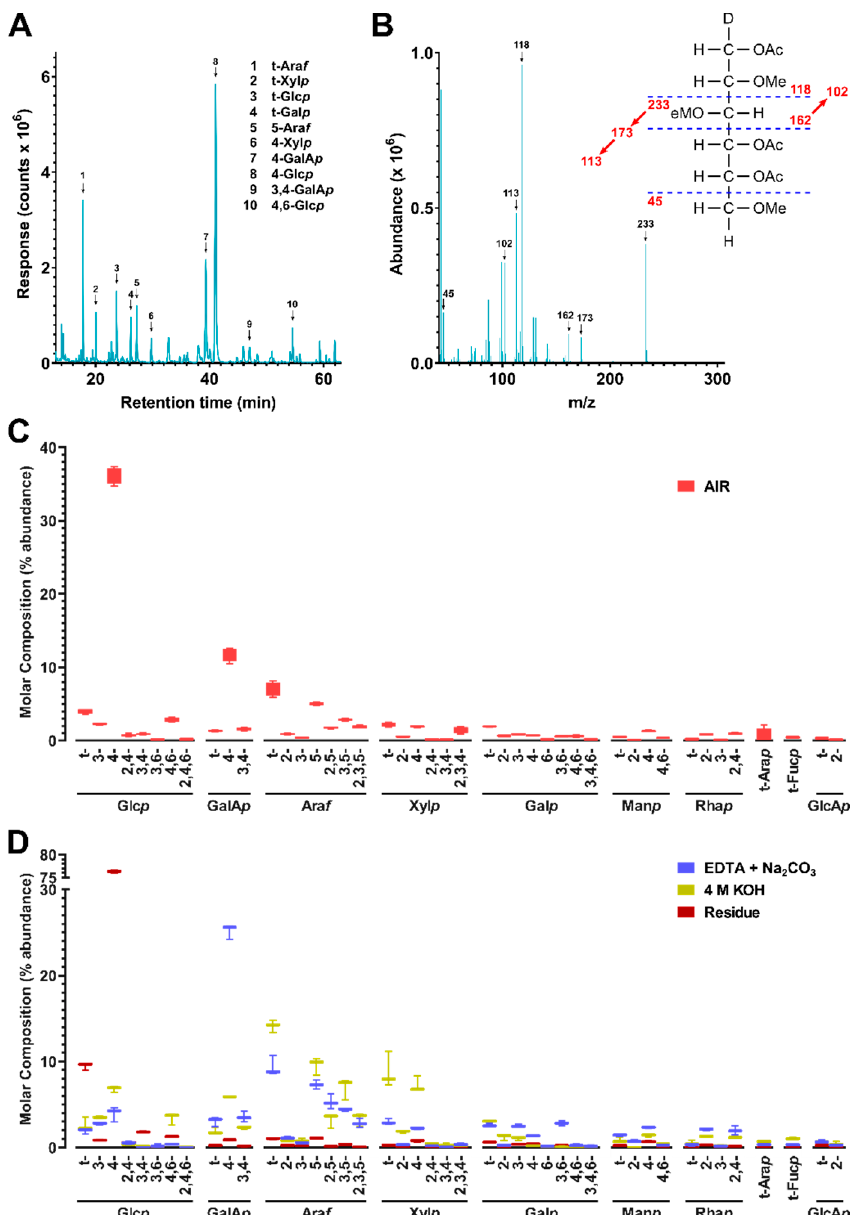
Figure 2. Cell wall linkage composition of cold-pressed canola meal. ( A ) Total ion current (TIC) chromatogram of cold-pressed canola meal (CM) non-starch polysaccharides (NSP) analyzed by PMAA gas chromatography-mass spectrometry (GC-MS). ( B ) Mass spectrum of example PMAA from 4-Glc p ( β -1,4-linked glucopyranose). Peaks in TIC chromatogram ( A ) were assigned to linkages based on their MS fragmentation patterns and retention times by referring to those of standards. ( C , D ) Calculated relative composition of linkages (molar%) from peaks shown in ( A ) for ( C ) CM alcohol insoluble residue (AIR) and ( D ) fractionated extracts of EDTA + Na 2 CO 3 , 4 M KOH, or residue A pre-treatment of NaBD 4 was conducted to the cell wall before its sequential fractionation in order to increase the extricability of polysaccharides. Four separate experiments were conducted to cell wall and three to each fraction. Values are averages from the separate experiments, presented as bar and whiskers with error bars representing the standard deviation from the mean.